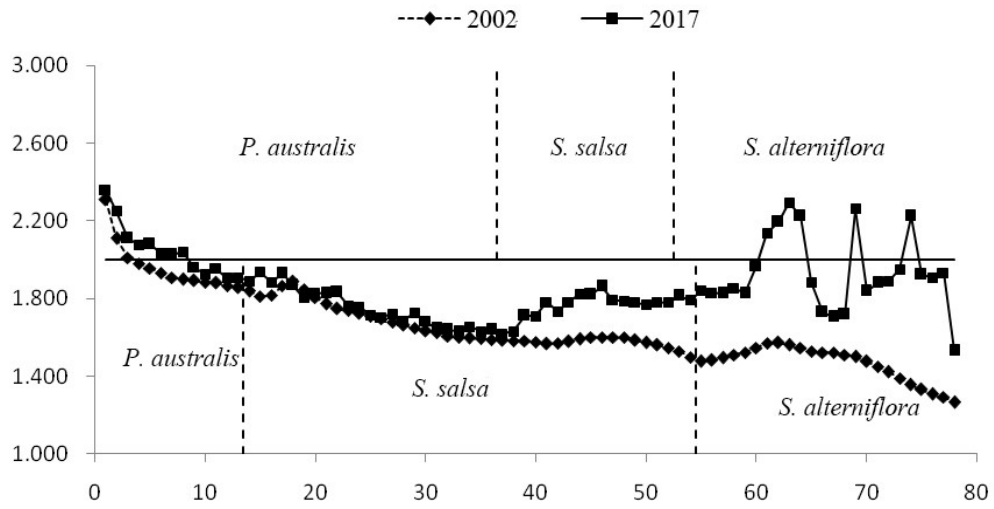
Figure 11. The elevation changes in the cross-section of the coastal wetland in Yancheng.